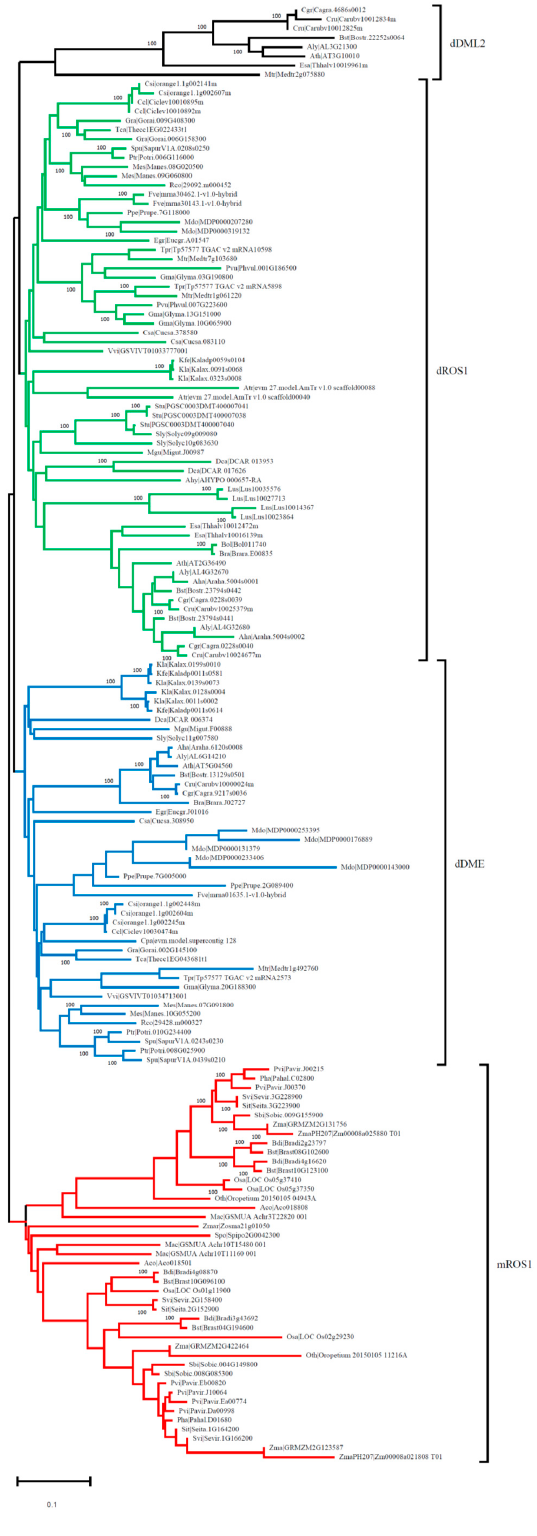
Figure 2. Phylogenetic analysis of the ROS1 and ROS1 -like DNA glycosylase family. A phylogenetic tree based on conserved DNA glycosylase domain was constructed. Monocot ROS1 (mROS1) proteins are shown in red color, while dicot DME (dDME), dicot ROS1 (dROS1) and dicot DML2 (dDML2) proteins are shown in blue, green and black, respectively. Protein sequences were downloaded from Phytozome (https://phytozome-next.jgi.doe.gov) (accessed on 19 October